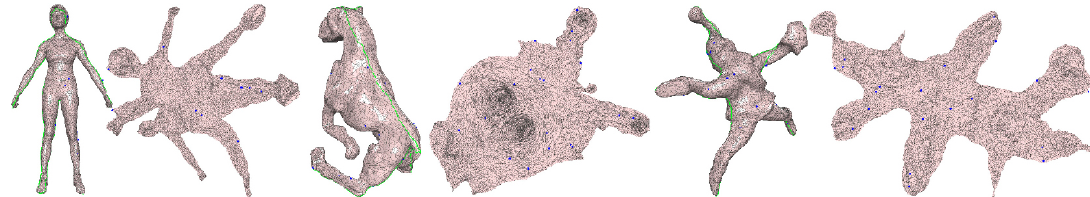
Fig. 2 Our method succeeds in constructing globally injective parameterizations with positional constraints for three complex